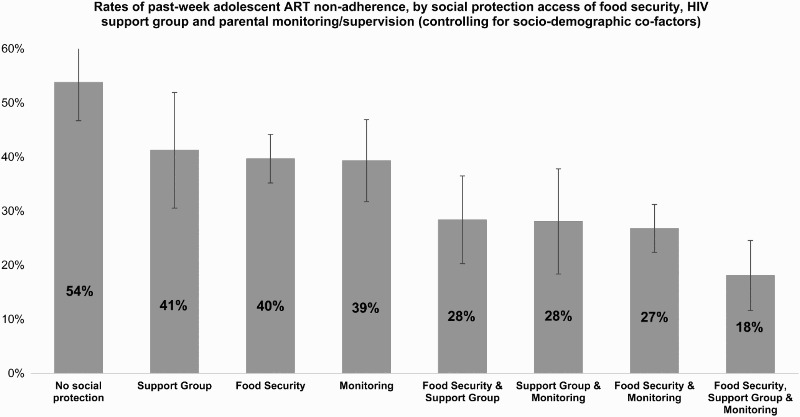
Marginal effects model testing for additive effects of combination social protections on adolescent ART-adherence.